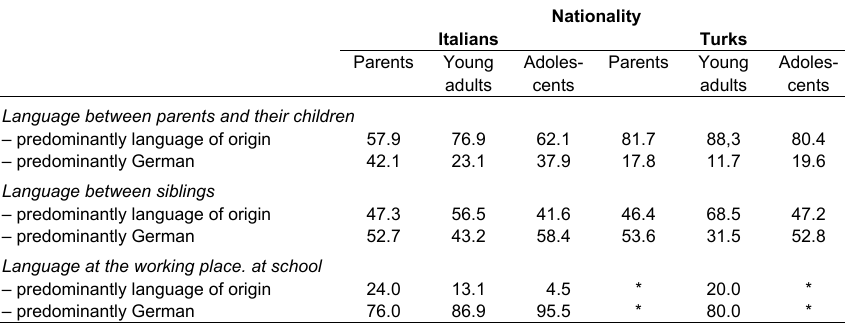
Data base: Survey “Intergenerational relationships in migrant families”; DJI Youth Survey 1997; * = not